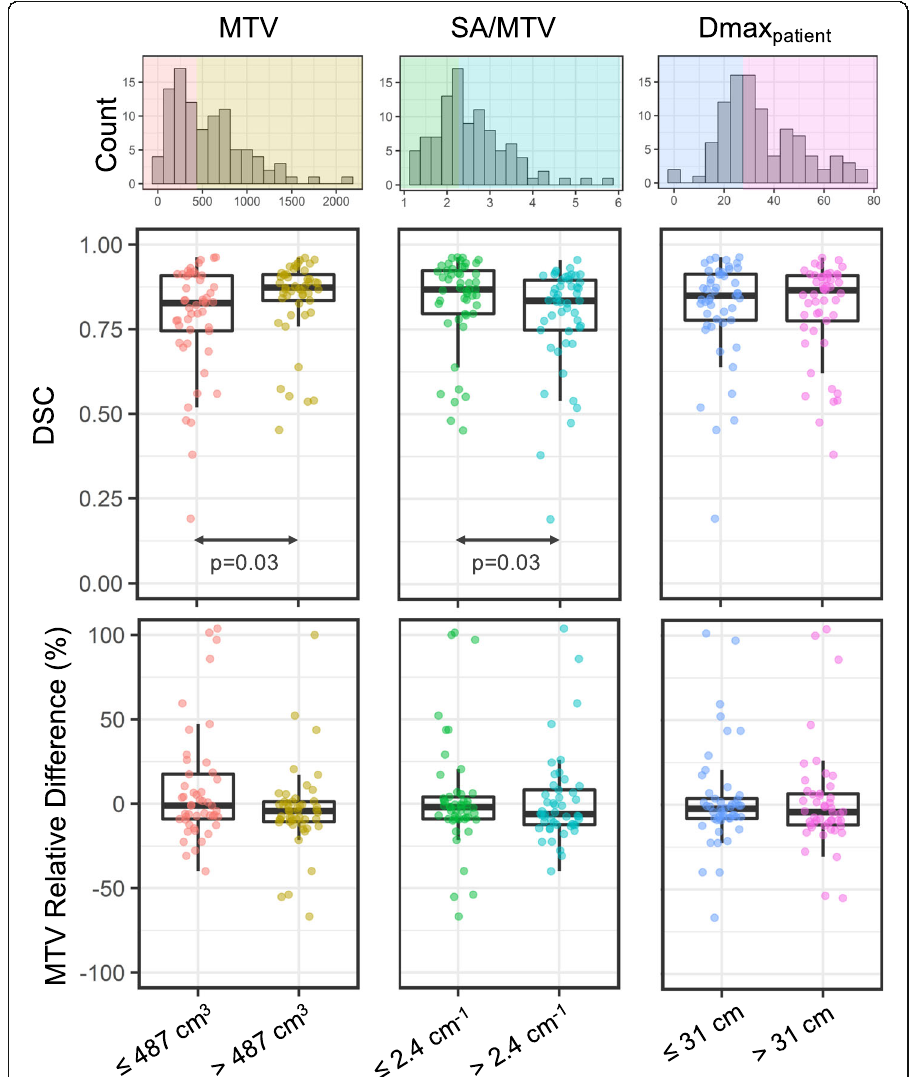
Fig. 6 Subgroup analysis of the model ’ s segmentation and quantification performance. Disease was dichotomized by MTV (left), surface-area-to-volume ratio (SA/MTV, center), and dissemination of disease (Dmax patient , right) based on median values. Note plots are cropped, concealing an outlier at approximately 200% MTV RPD, for better visualization. Histograms in the top row show the spread of characteristics and are colored by median